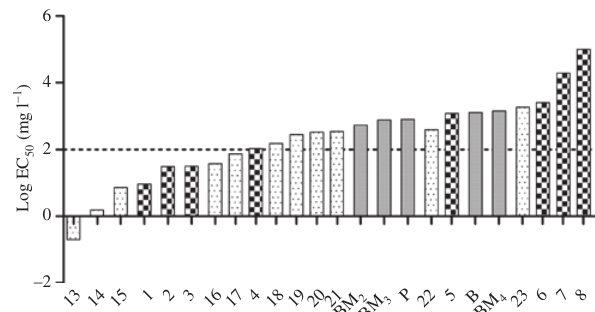
graphical comparison of toxicity in Vibrio fischeri. Figure 3: Log EC 50 The codification is shown in Table 2. Pointed bars correspond with imidazolium ILs, squared bars correspond with traditional solvents and grey bars correspond with the studied ILs. The dashed line shows the limit between slightly toxic and practically harmless compounds according to Passino and Smith